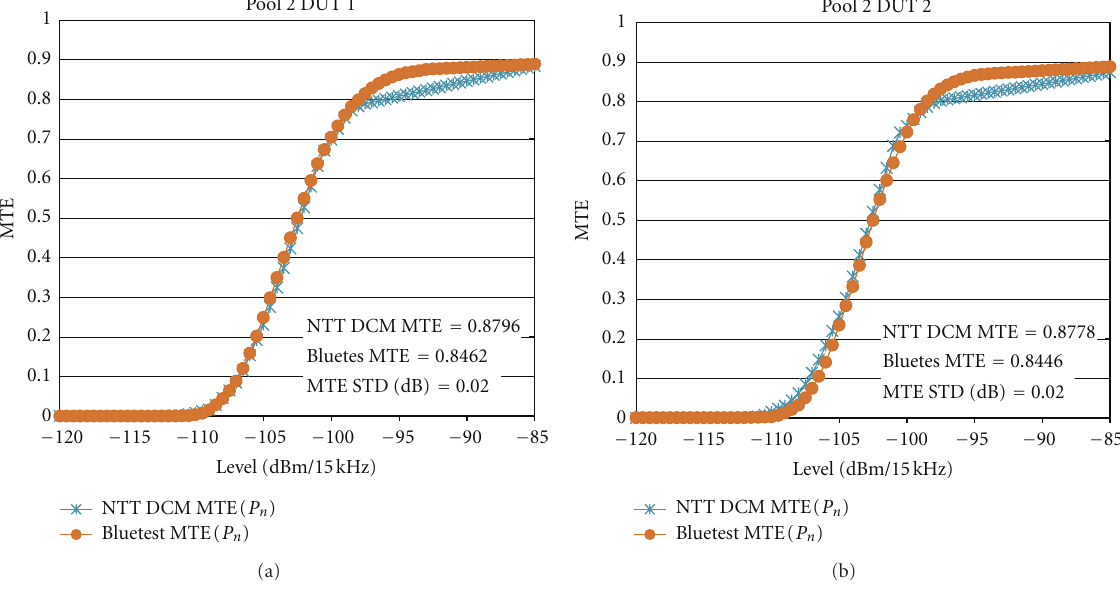
Figure 2: MTE for Pool 2 with the RC